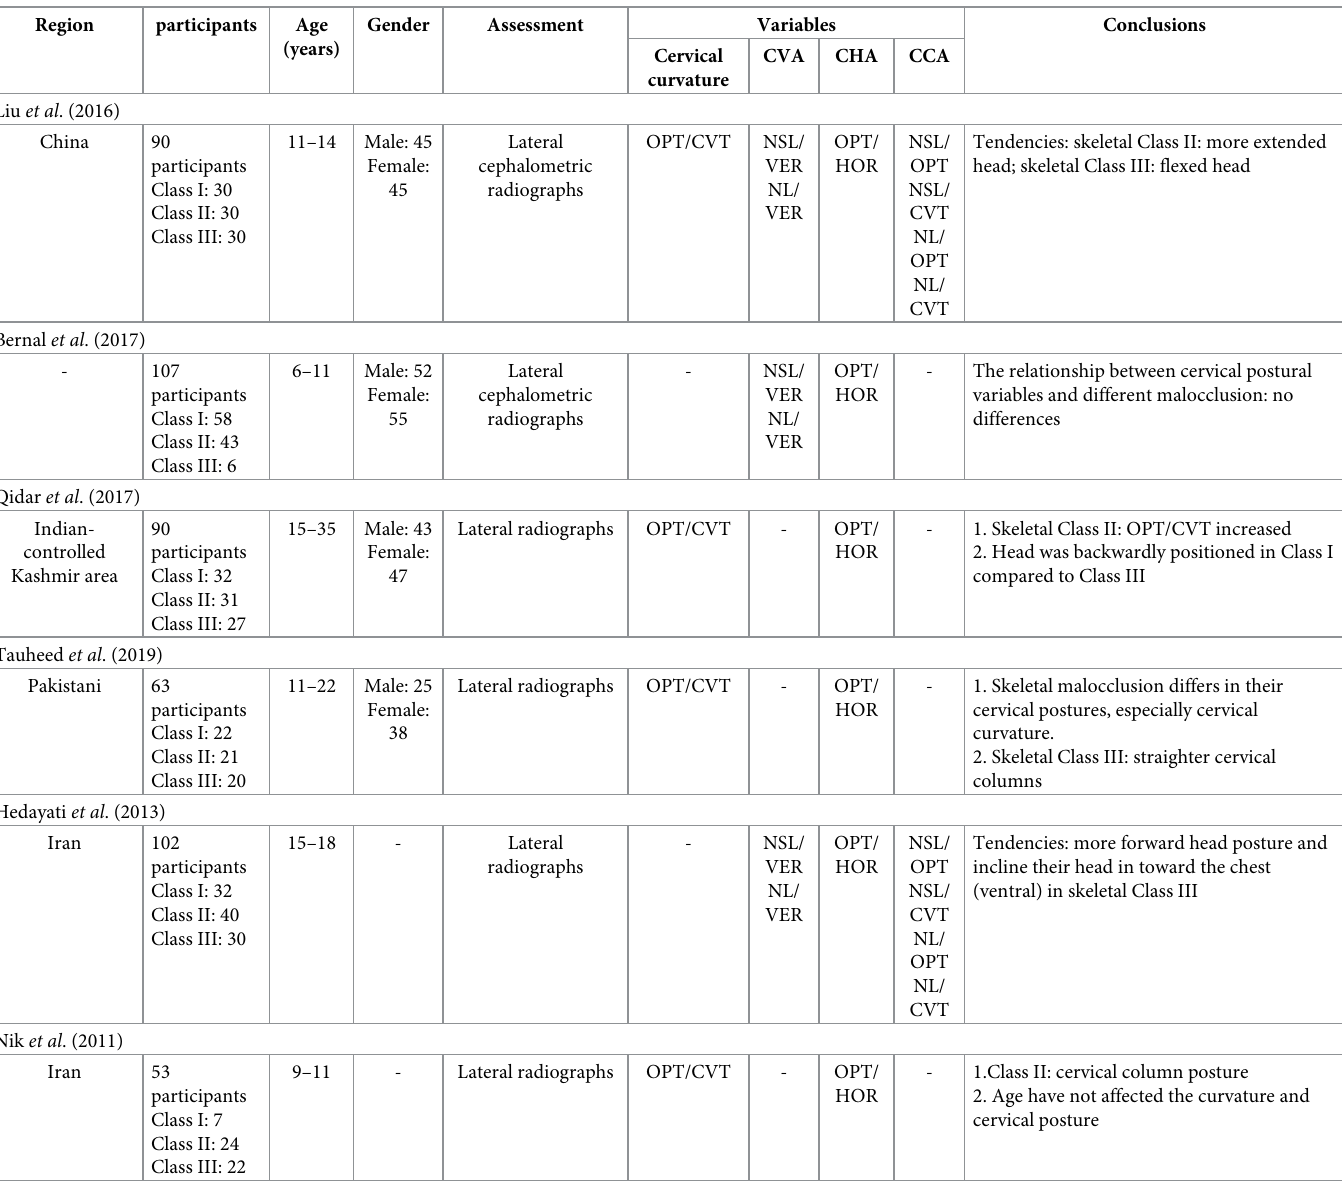
Table 2. Characteristics of included studies.